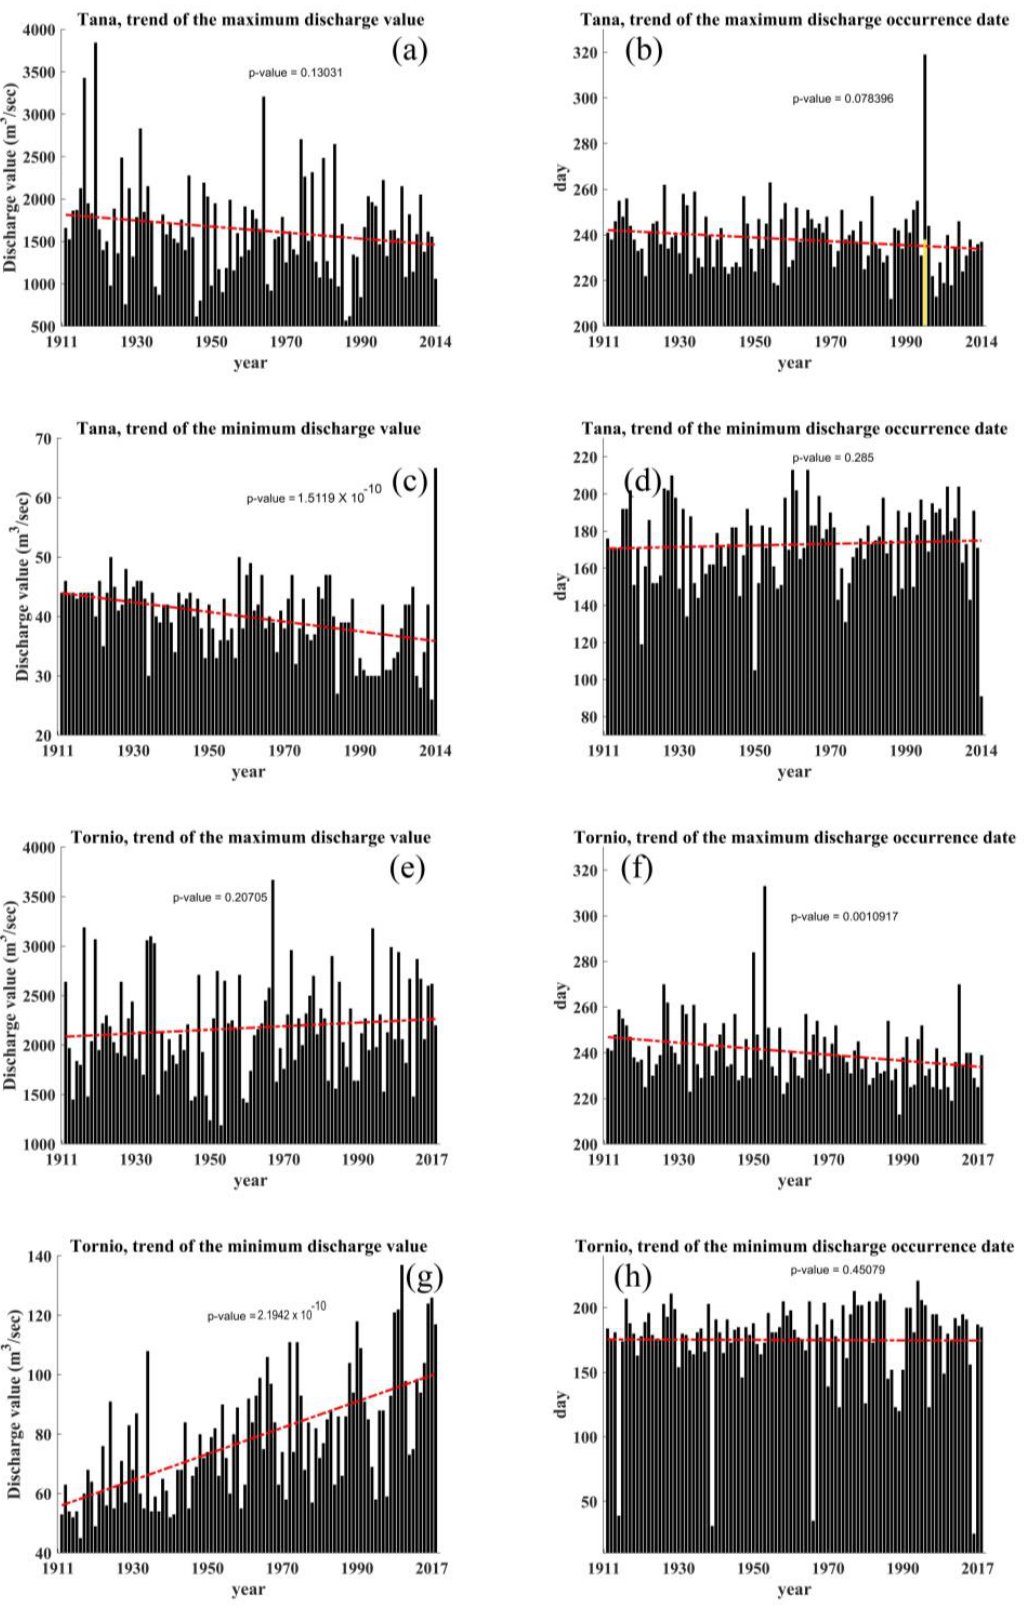
Figure 7. The trend of annual discharge extremes and their corresponding date for Tana and Tornio.